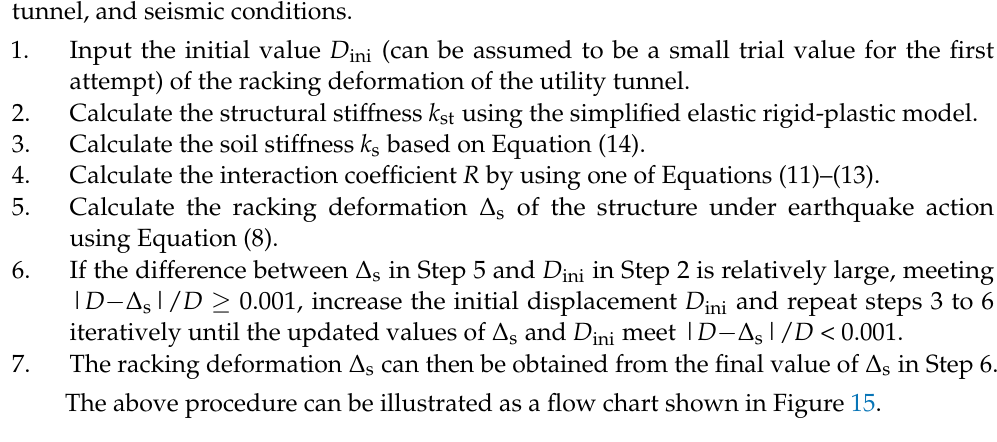
Figure 15. Flow chart of the procedure to obtain racking deformation.